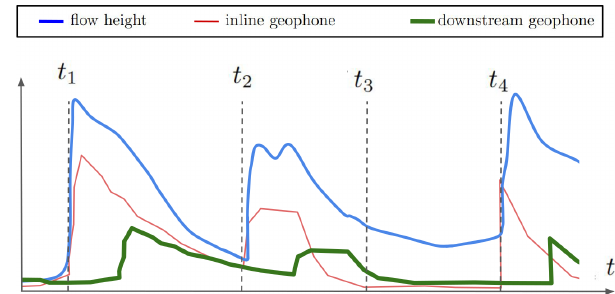
Figure 2. Conceptual graph explaining the surge identification ap- proach: t 1 marks the onset of the first surge, with a sharp increase in energy in the geophone aligned with the flow sensor and sharp increase in directly measured flow height; t 2 marks the end of the first surge and the start of the second surge, with geophone activity decreasing before a sharp increase due to a second surge; t 3 marks the end of the second surge, with seismic activity being negligi- ble even though the flow height is still high – those are the diluted runoff flows; and t 4 marks the start of the third surge. Note that even though the second surge has two peaks on the flow height, it is seen as one surge due to continuous seismic